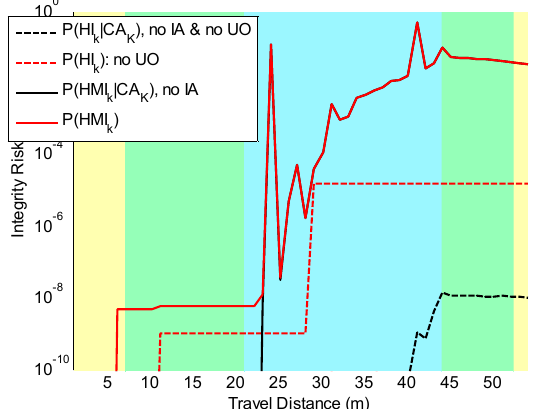
Figure 3. P ( HMI k ) bounds taking into account the possibility of IA and the potential presence of UOs. The difference between the dashed black line and the solid black line quantifies the impact on P ( HMI k ) of undetected UOs when assuming correct association (CA). The difference between the dashed red line and the solid red line measures the impact on P ( HMI k ) of undetected UOs when accounting for incorrect associations. Sensors 2018 , 18 , x